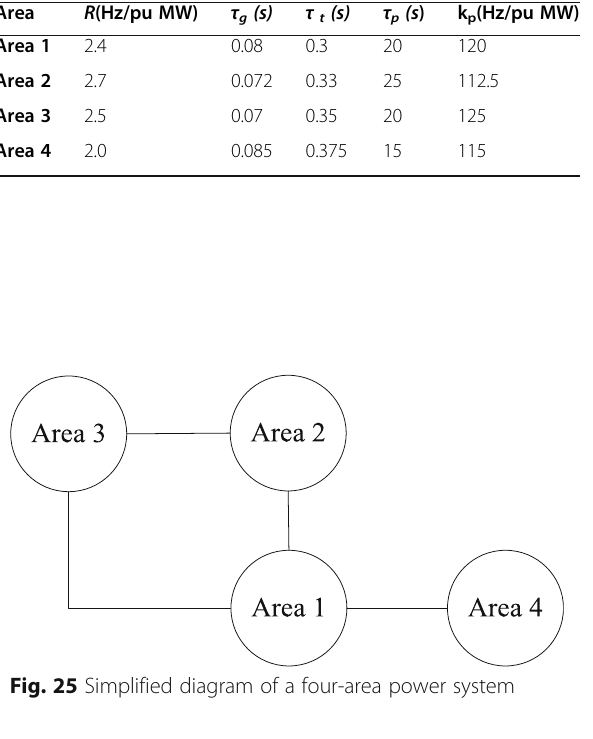
Table 5 Parameters of four-area LFC system for case study 6